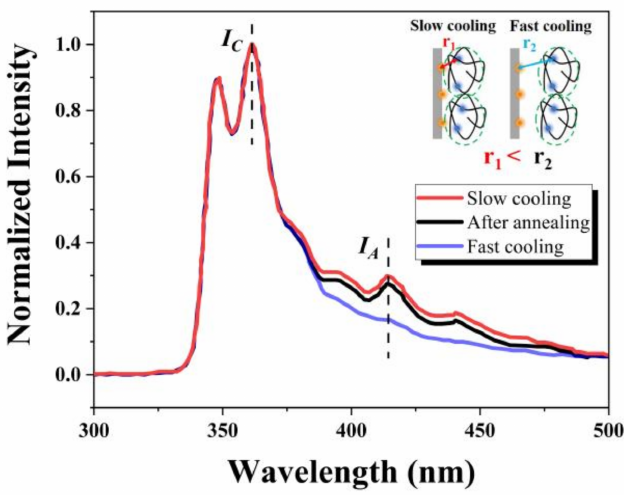
Figure 5. Fluorescence spectra of PBMA-Cz@AAO-An after different thermal treatments. The interfacial proximities after slow cooling, fast cooling and annealing are illustrated